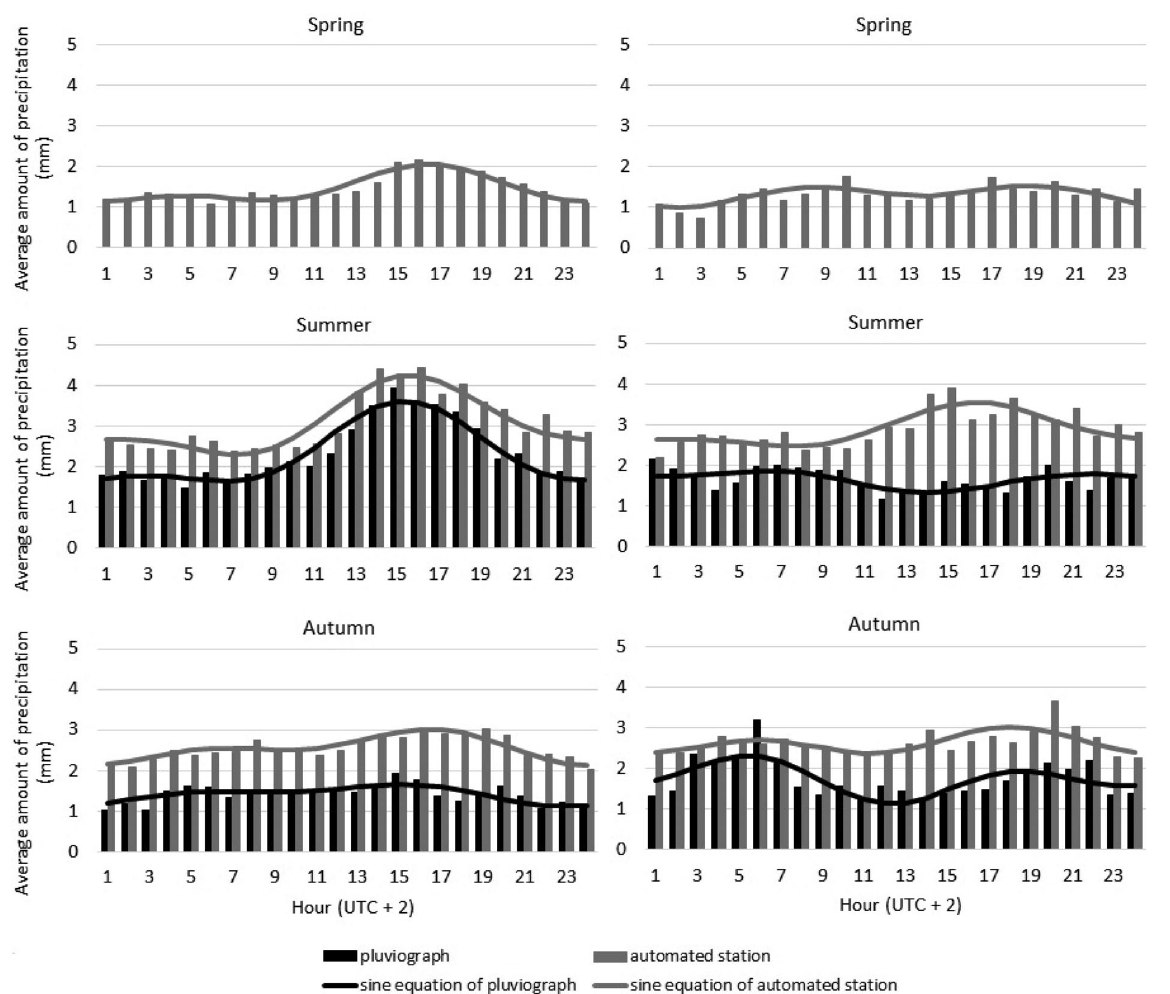
Fig. 4. Mean diurnal distribution of hourly precipitation amounts (mm) in Estonia by seasons at the continental (left panel) and coastal stations (right panel), calculated from the pluviographic records in 1991–2003 (black columns) and from the automated precipitation gauges in 2003–2013 (grey columns). Thick lines present the approximating diurnal curves of